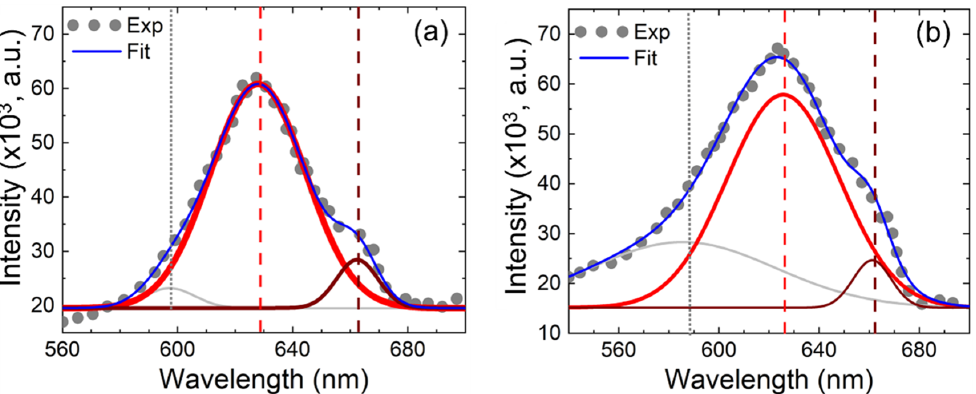
Figure 3. Photoluminescence spectra of Cu x O thin films for as-deposited ( a ) and annealed (40 min) films ( b